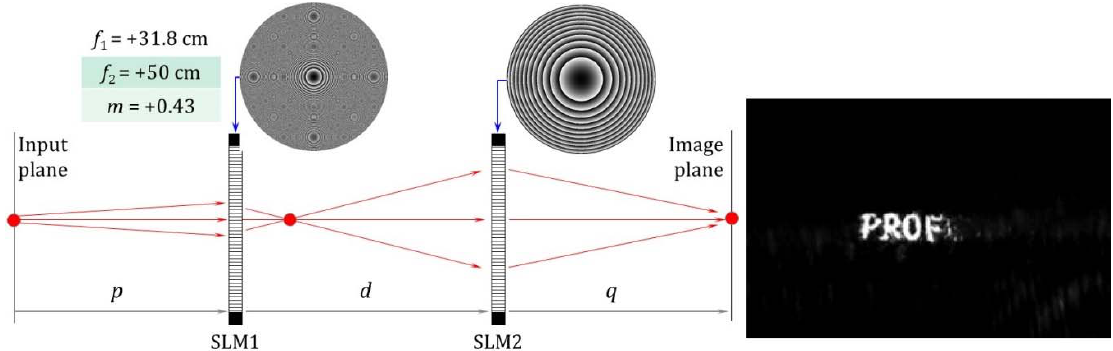
Figure 7. Zoom system configuration with f 1 = +50 cm and f 2 = +31.8 cm and experimental image with magnification of m = +2.